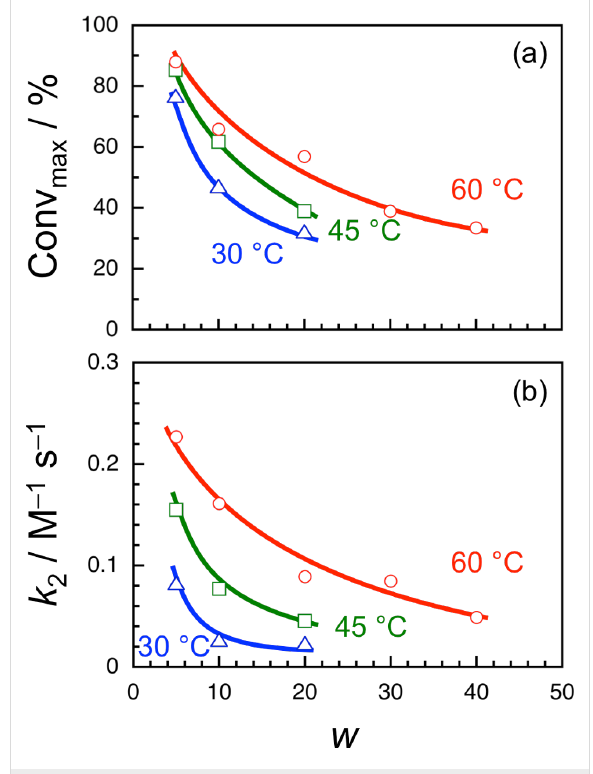
Figure 3: Conv max and k 2 as function of w for formose reactions in water pools of AOT reverse micelles at 30 (triangle), 45 (square), and 60 °C (circle). The curves are drawn as a guide for the